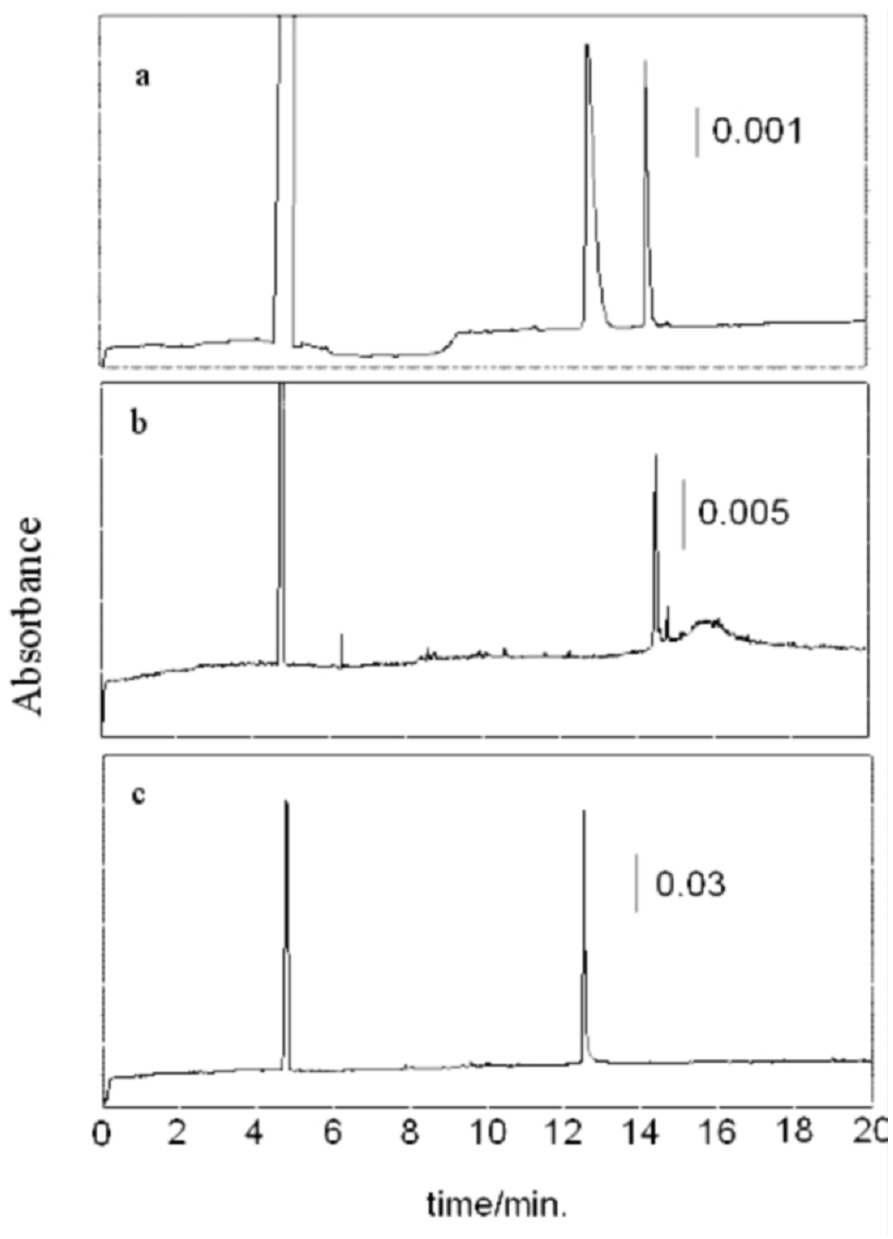
Figure 8. CZE separation of 2.4 nm and 4.3 nm SDS coated CdSe/TOPO QDs. (a) injection of mixture of 2.4 nm and 4.3 QDs (sample: a mixture of 500 mM SDS solutions of QDs; injection 35 mbar, 5 s); (b) injection of 4.3 nm QD; (c) injection of 2.4 nm QD (b and c samples were